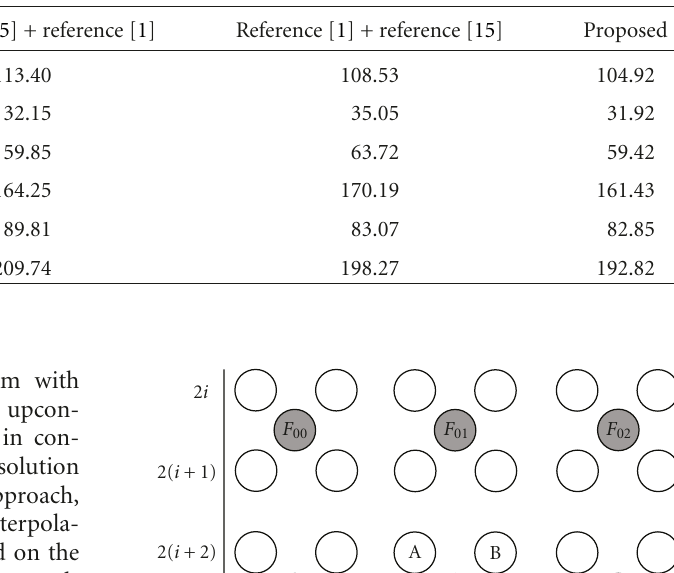
Table 3: MSE comparison of di ff erent algorithms.